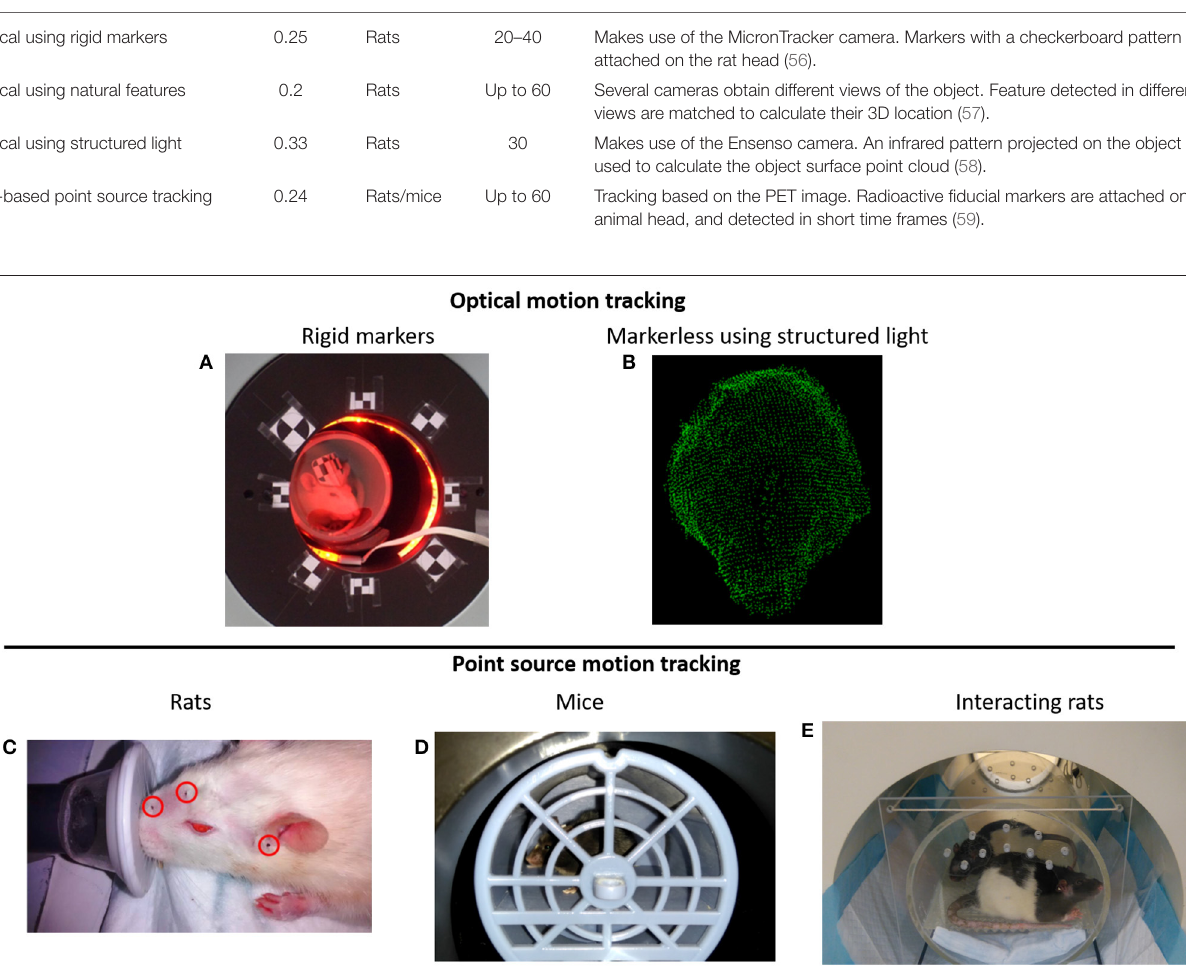
TABLE 2 | Characteristics of the different motion tracking techniques for small animal brain PET. Tracking method